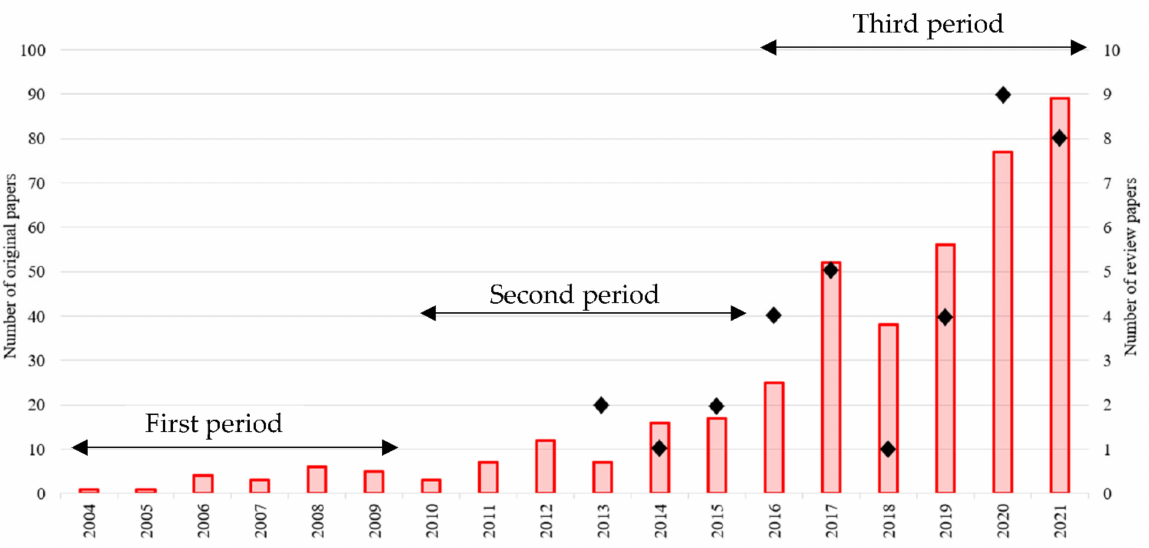
Figure 4. Published original and review papers in the IEQMI field.